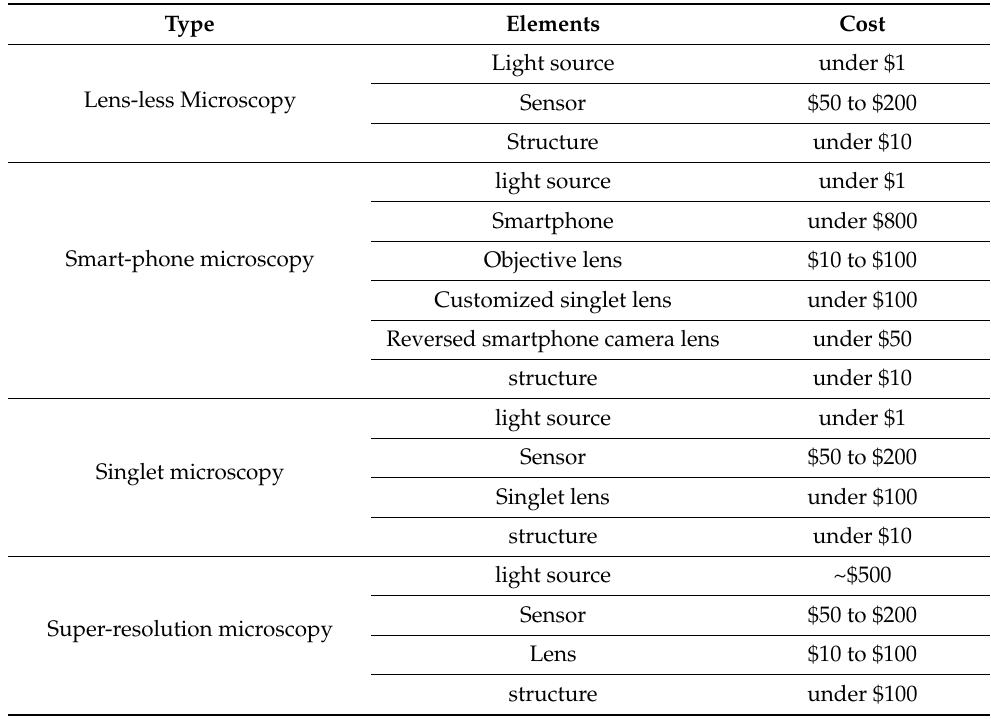
Table 1. Estimated prices of key optical and electronic elements in computational portable micro-